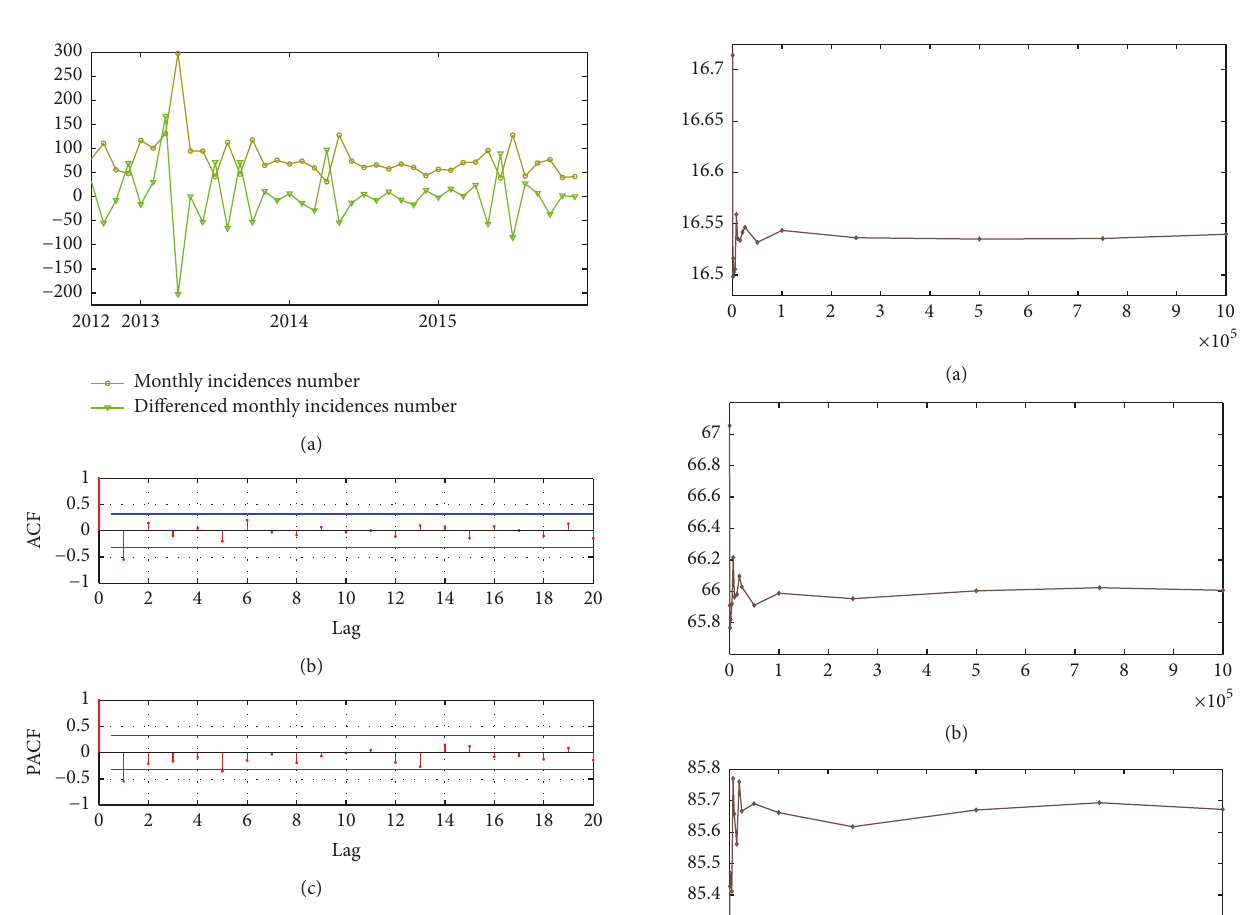
Figure 5: (a) Monthly number of incidents is plotted against its first differenced series, acf (b) and pacf (c) plots for its first difference in monthly number of incidents.